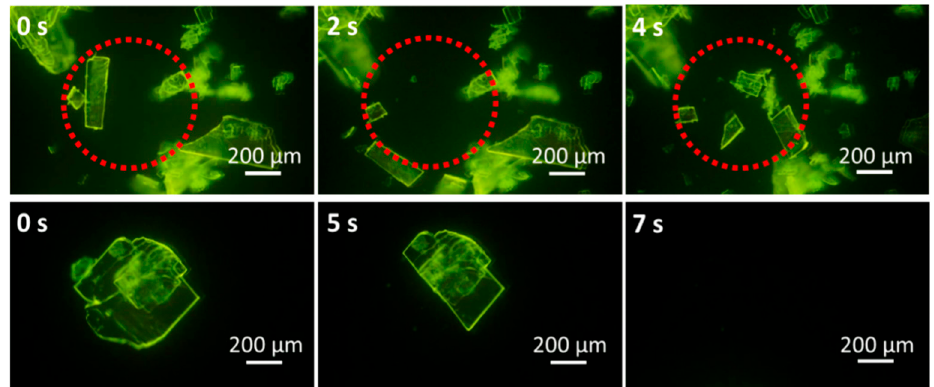
Figure 3. A series of microscopic images showing the jumping and splitting behavior of crystal 1 under UV light (crystals jump away and back in the red circle).